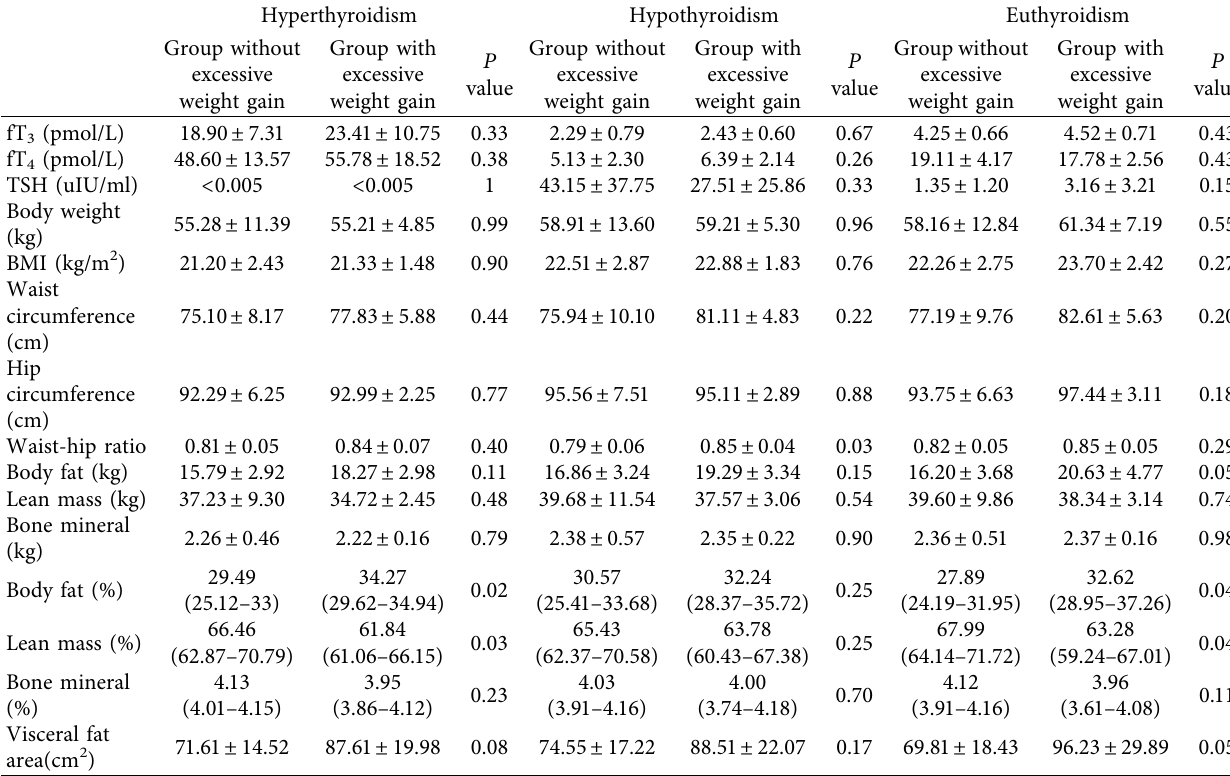
Table 3: Comparison of anthropometric and body composition parameters between the group with excessive weight gain and the group without excessive weight gain under different thyroid function states.